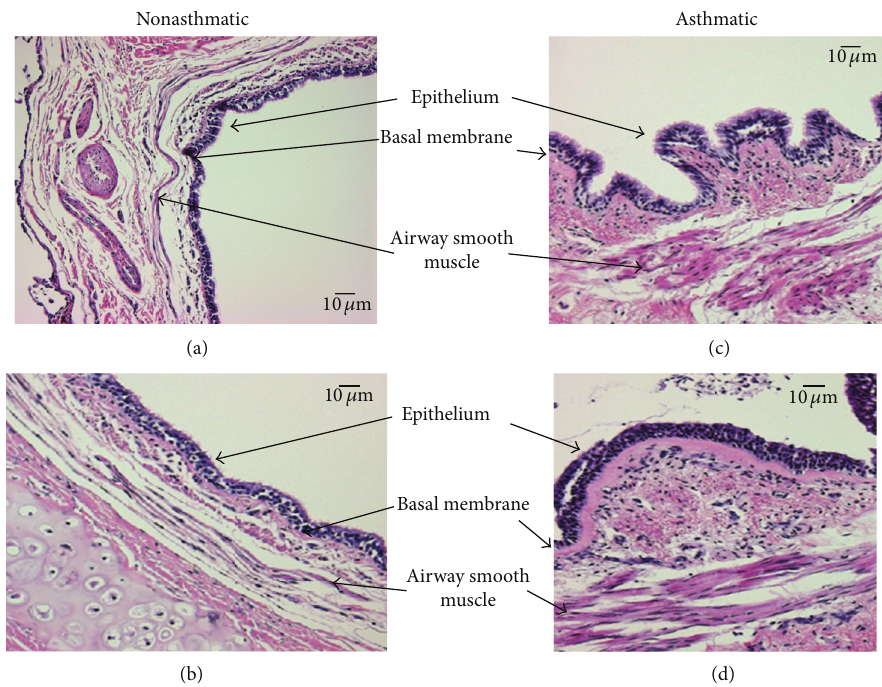
Figure 1: Histological tissue sections of two patients with moderate asthma and two nonasthma controls. Arrows indicate the loss of epithelium integrity, the increase of the basement membrane thickness, and the increased number of ASM bundles in the asthmatic airways (c, d), compared to nonasthmatic airways (a,